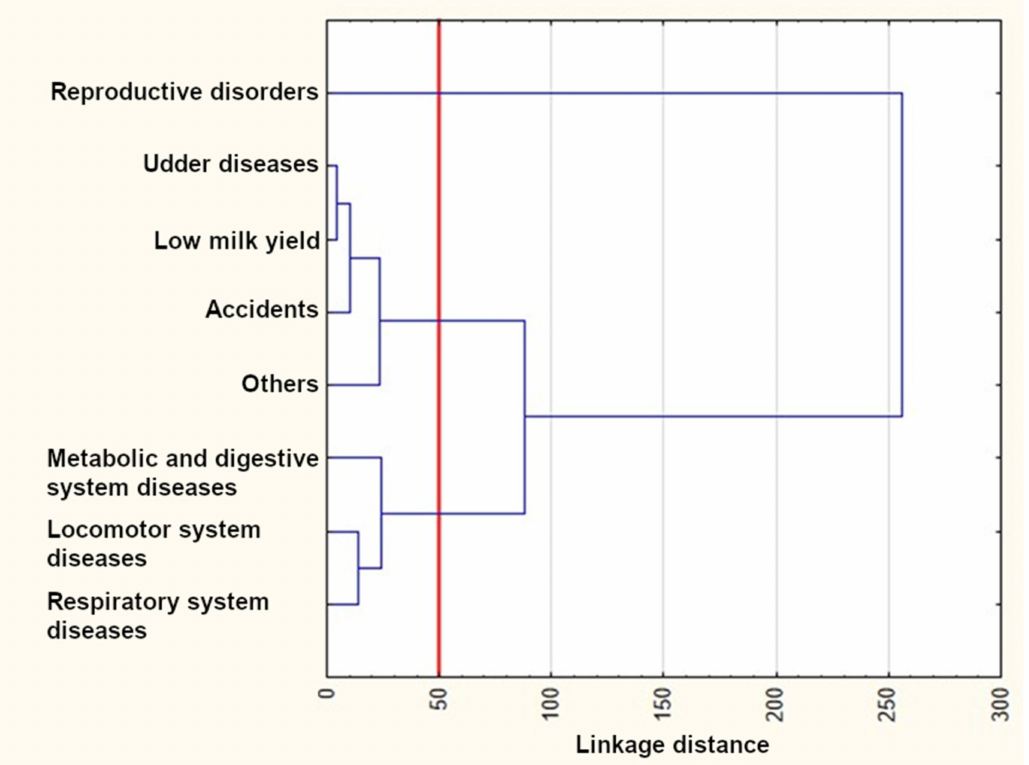
Figure 4. The results of the cluster analysis using Ward’s method for the first